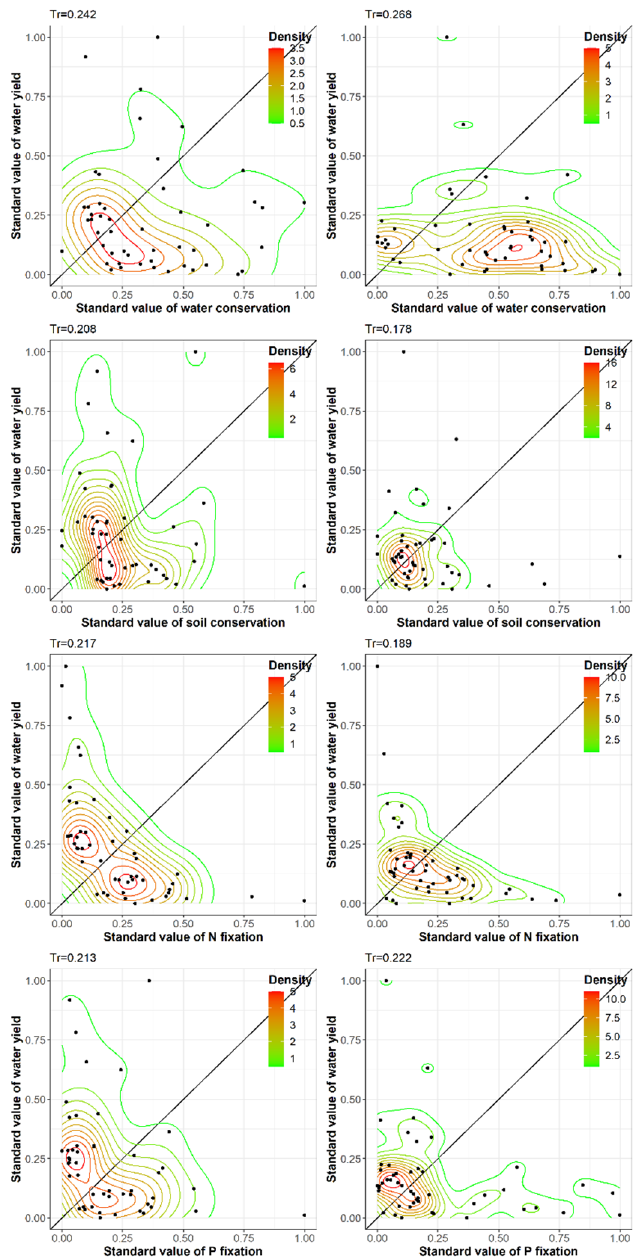
Figure 9. ESs trade-off intensity of 2000 ( left column ) and 2016 ( right column ). Tr indicates trade-off intensity. The area with dense contours has dense point distribution, and the overall trend of point distribution can be identified by the change of contour distribution.